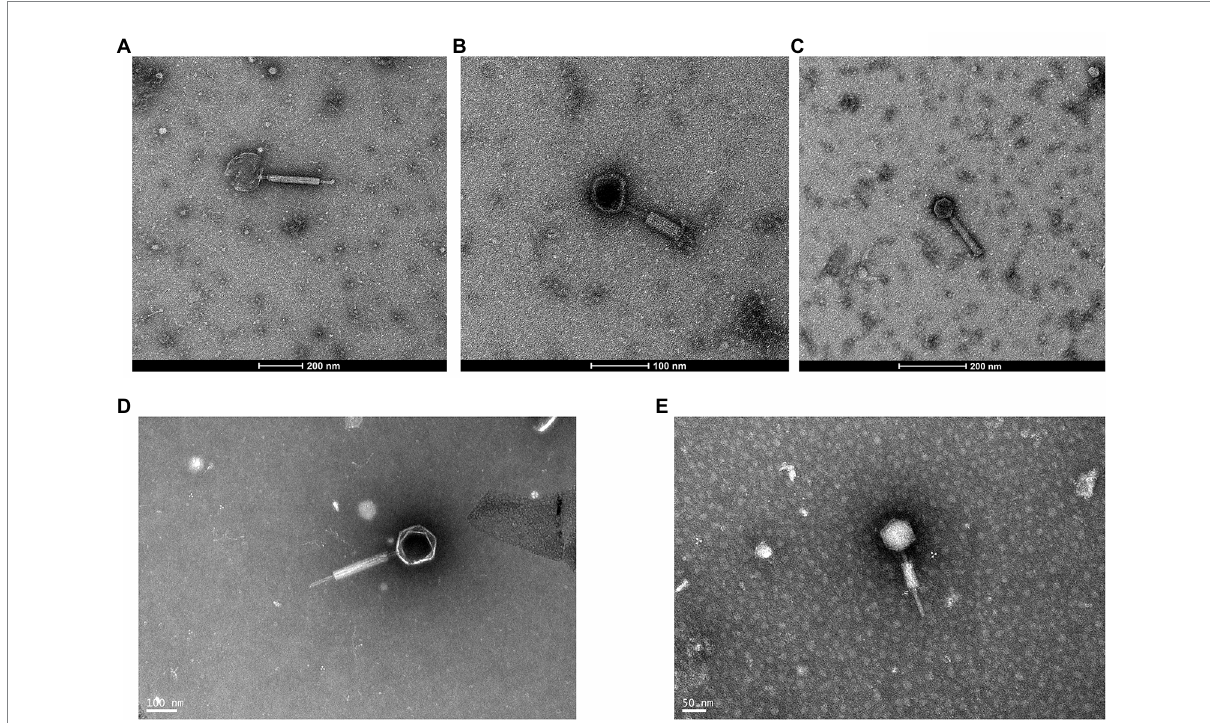
FIGURE 1 TEM micrograph of phages JD-Fnp1 ~ JD-Fnp5. (A) JD-Fnp1. The length and width of the head are 155 ± 5 nm and 140 ± 5 nm respectively, and the length of its retractable tail is 335 ± 5 nm. Magnification: × 36 k. (B) JD-Fnp2. The length of its head is 60 ± 2 nm, and the width is 50 ± 3 nm. The retractable tail is 130 ± 5 nm in length. Magnification: × 73 k. (C) JD-Fnp3. It has a head of the polyhedron with a radial length of 55 ± 3 nm, and a retractable tail with a length of 135 ± 2 nm. Magnification: × 54 k. (D) JD-Fnp4. The diameter of the capsid head and the length of the flexible tail are about 130 ± 5 nm and 300 ± 4 nm. Magnification: × 98 k. (E) JD-Fnp5. The diameter of the capsid head and the length of the flexible tail are 61 ± 2 nm and 144 ± 5 nm. Magnification: × 150 k. These measurements were taken on 10 different